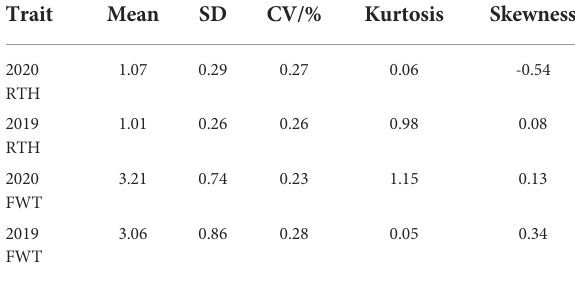
TABLE 1 Statistical analysis of rind thickness and single fruit weight of 151 watermelon accessions in 2019 and 2020.